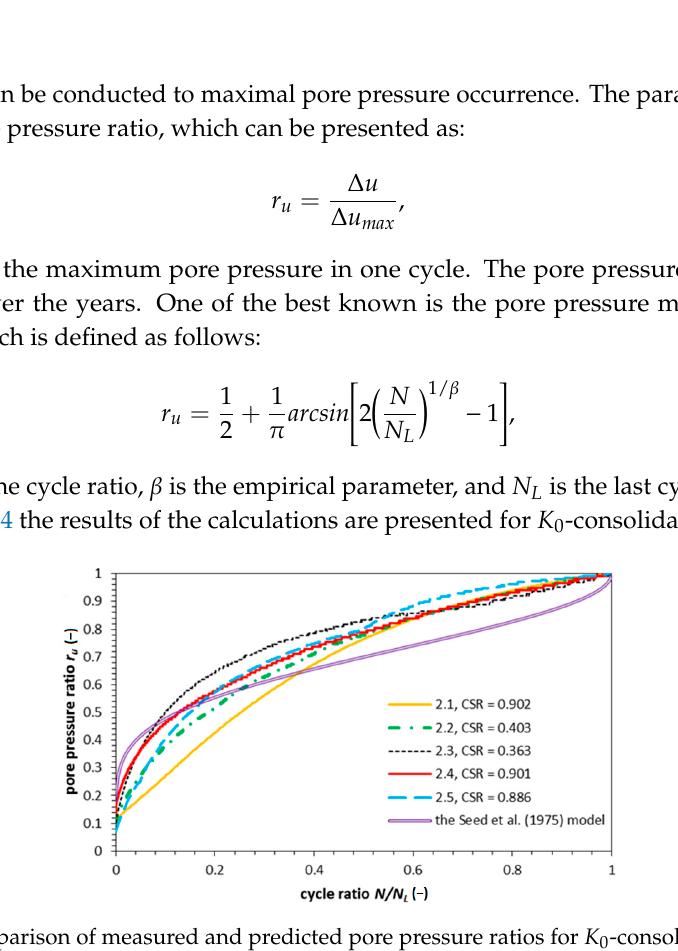
Figure 14. Comparison of measured and predicted pore pressure ratios for K 0 -consolidated samples.